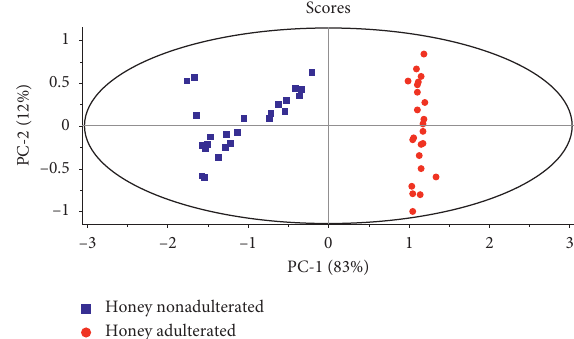
Figure 1: PCA scores plot of samples of pure honey and adul- terated